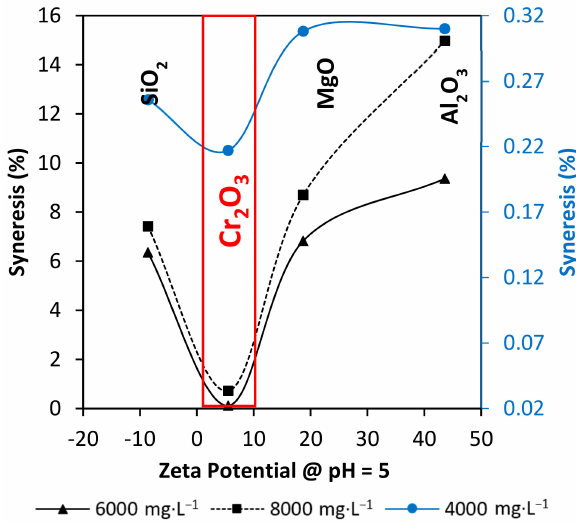
Figure 7. Correlation between nanoparticles Zeta Potential at the pH of work and syneresis development at 70 ◦ C on day